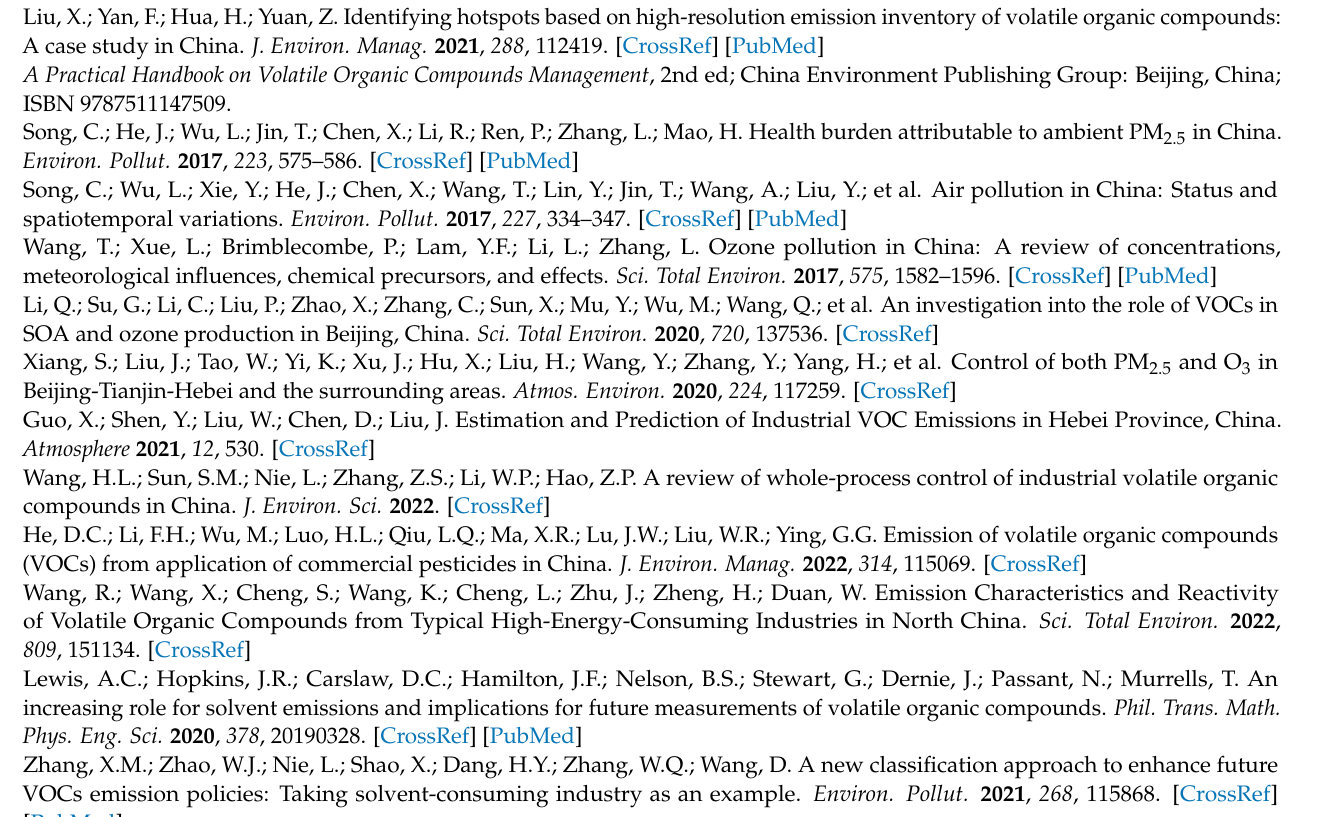
Table S2. Evaluation of the facility removal rate of VOCs in the pesticide industry. Table S3. Evaluation of the facility commissioning rate of VOCs in the pesticide